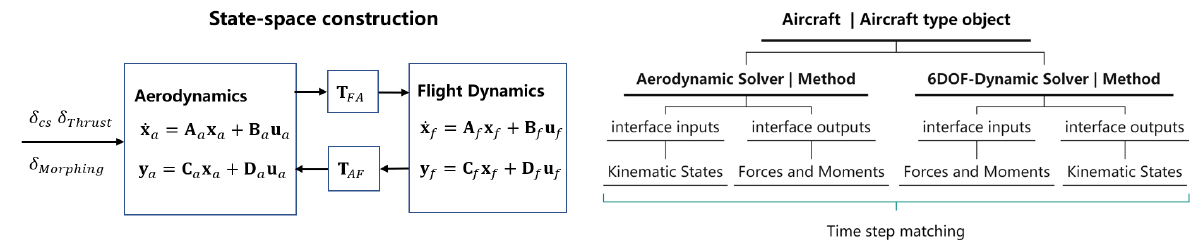
Figure 7. The illustration of the dynamic coupling using the state-space model ( left ) and the time- stepping model ( right